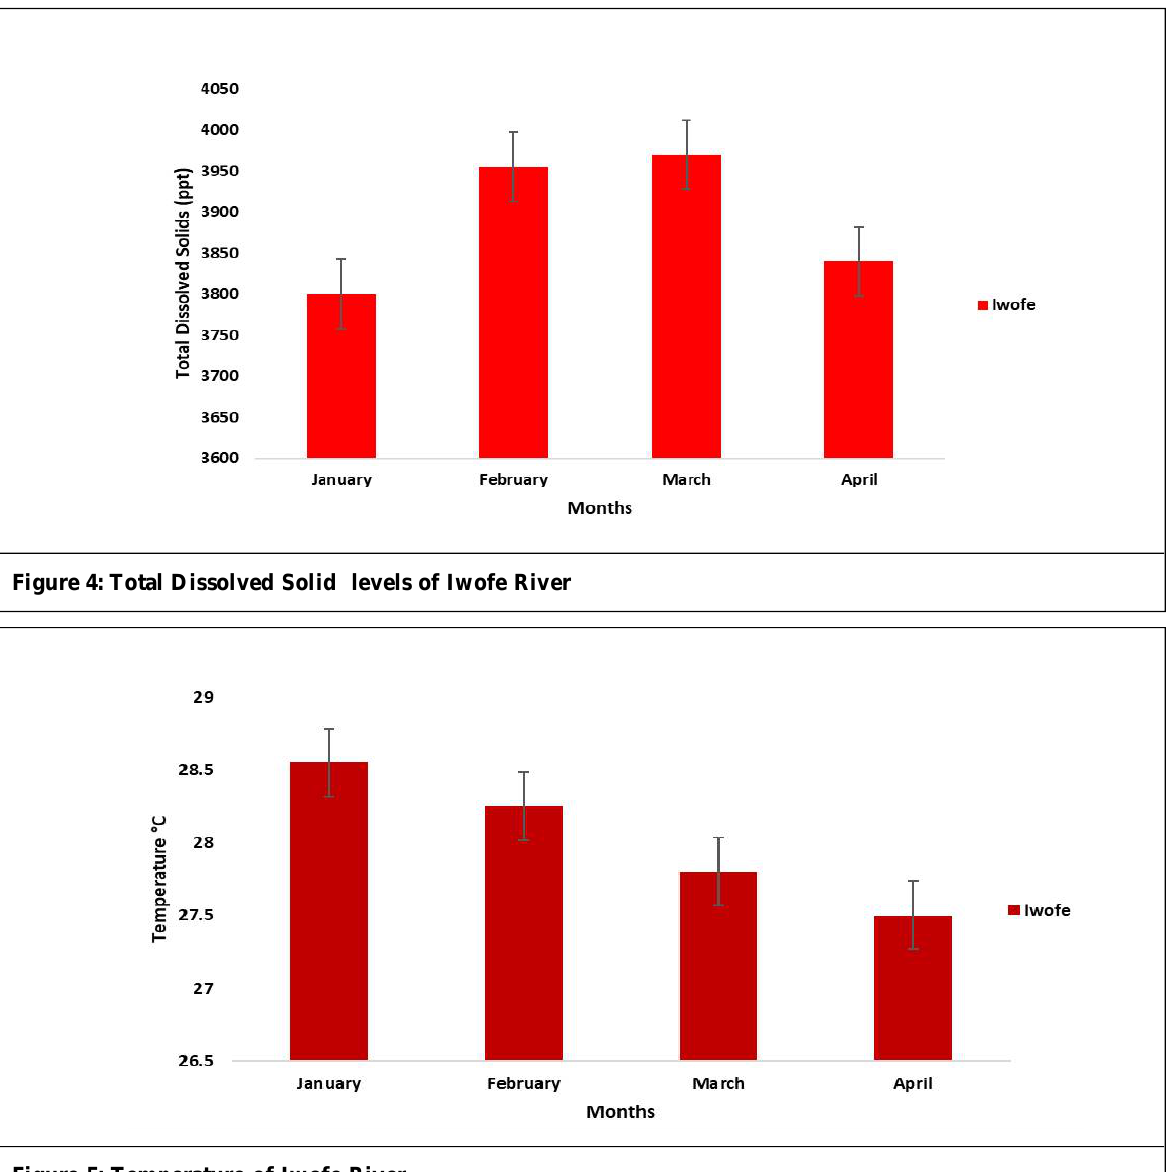
Figure 5: Temperature of Iwofe River